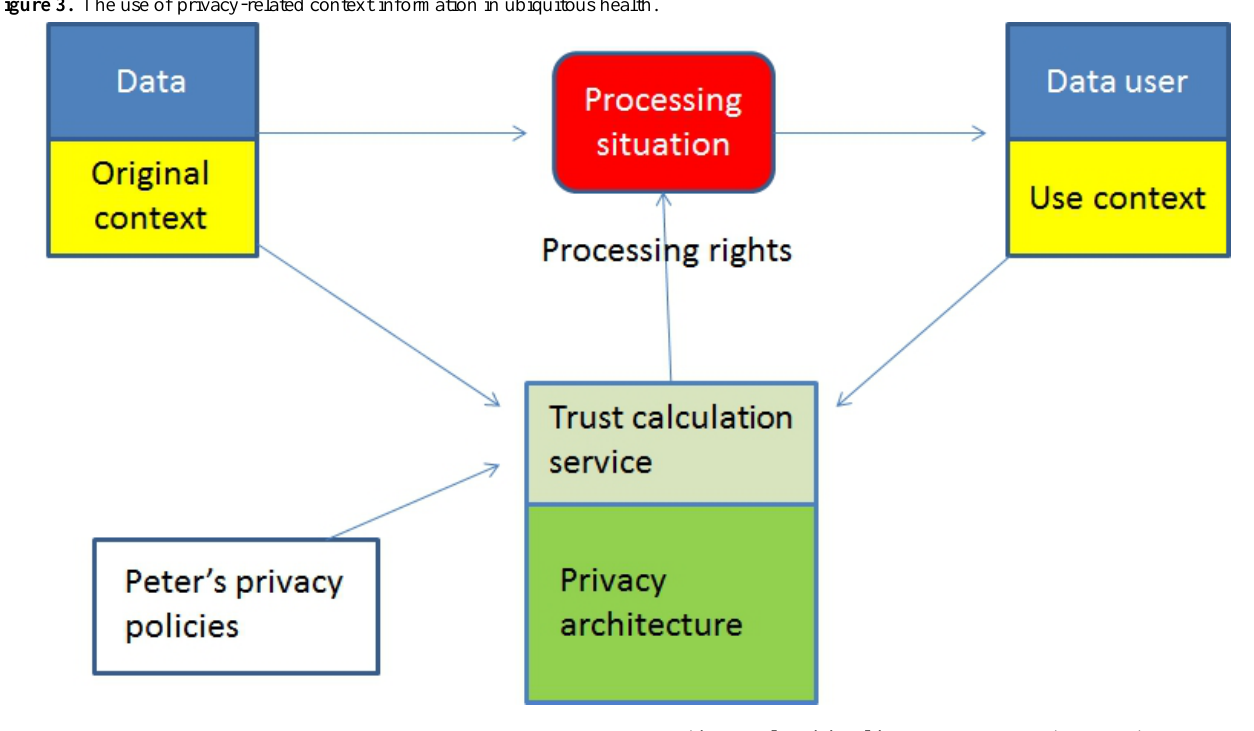
Figure 3. The use of privacy-related context information in ubiquitous